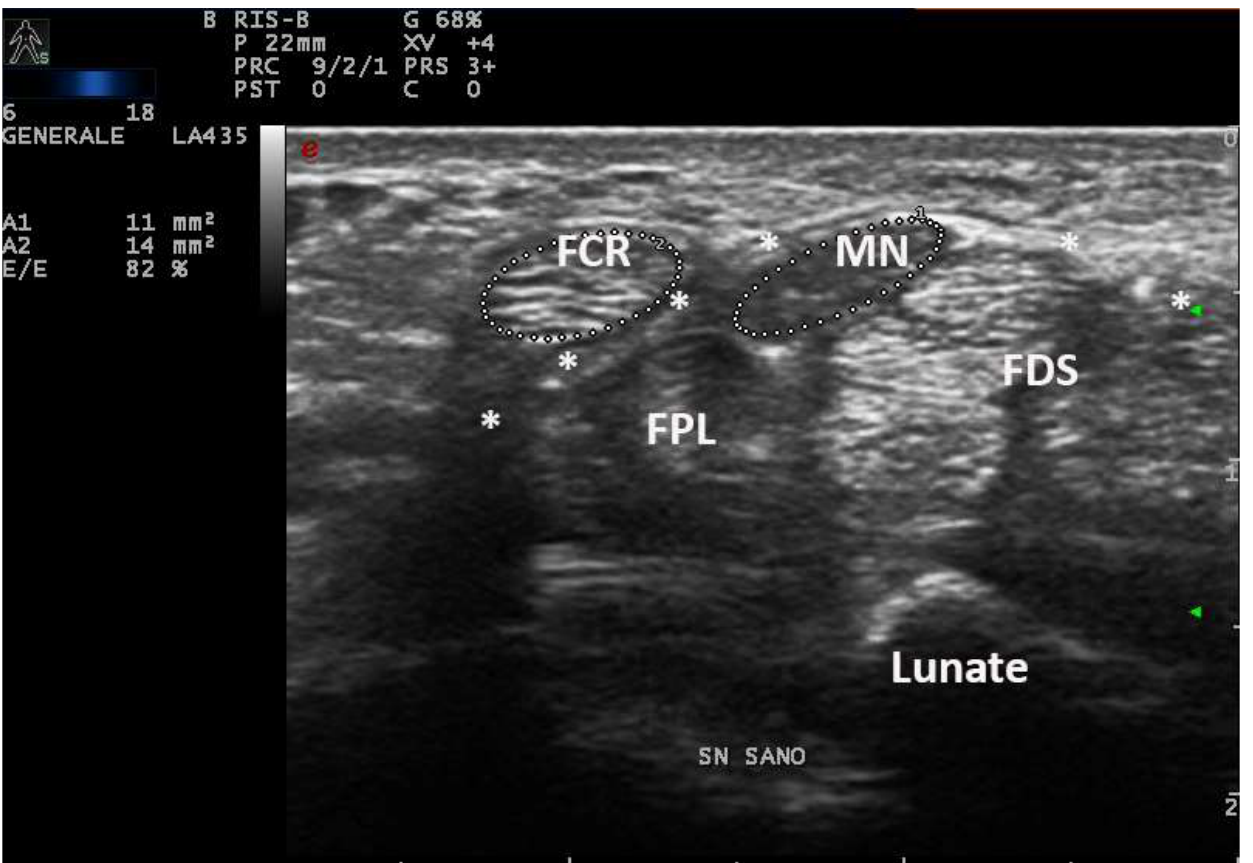
Figure 1. Transverse scan over left carpal tunnel of a tall male, asymptomatic for CTS in left hand (180 cm × 85 kg, 19 cm of wrist circumference). Linear 6–18 MHz probe. The MN-CSA (area 1) results of 11 mm 2 are suggestive of pathologic swelling, but EDS was normal (PS = 0, performed as control side, for CTS in the right side). The flexor carpi radialis (FCR) shows a CSA (area 2) of 14 mm 2 . MN = median nerve, FPL = flexor pollicis longus, * = transverse ligament, FDS = flexor digitorum